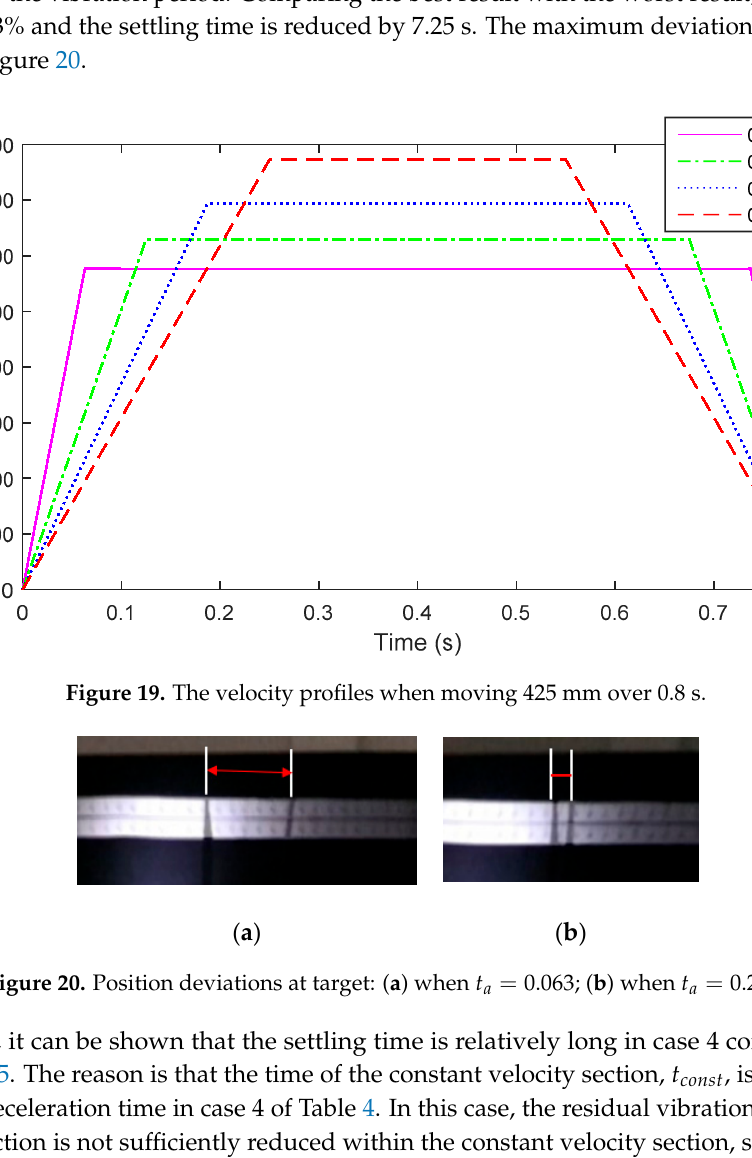
Figure 20. Position deviations at target: ( a ) when t a = 0.063; ( b ) when t a = 0.250.